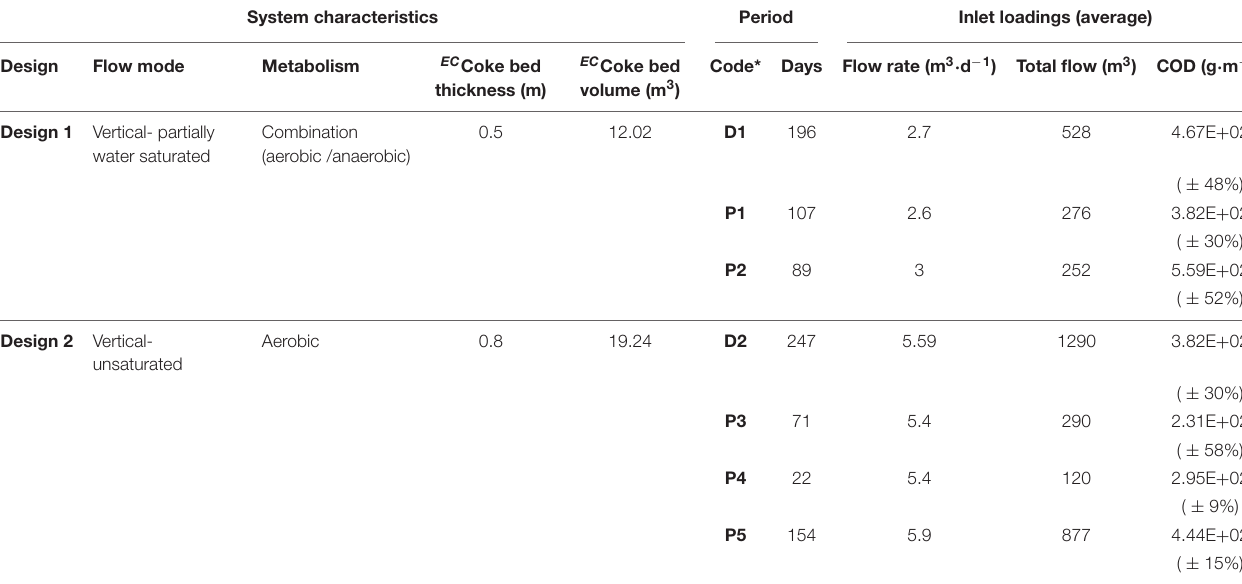
TABLE 1 | Summary of designs.